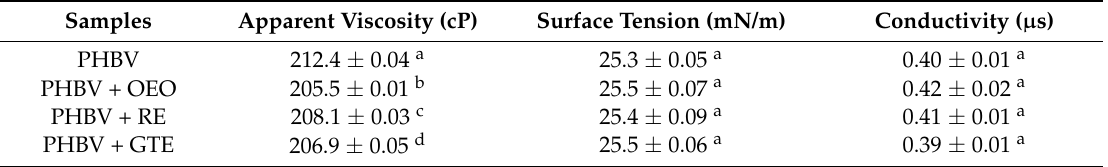
Table 1. Solution properties of poly(3-hydroxybutyrate- co -3-hydroxyvalerate) (PHBV)